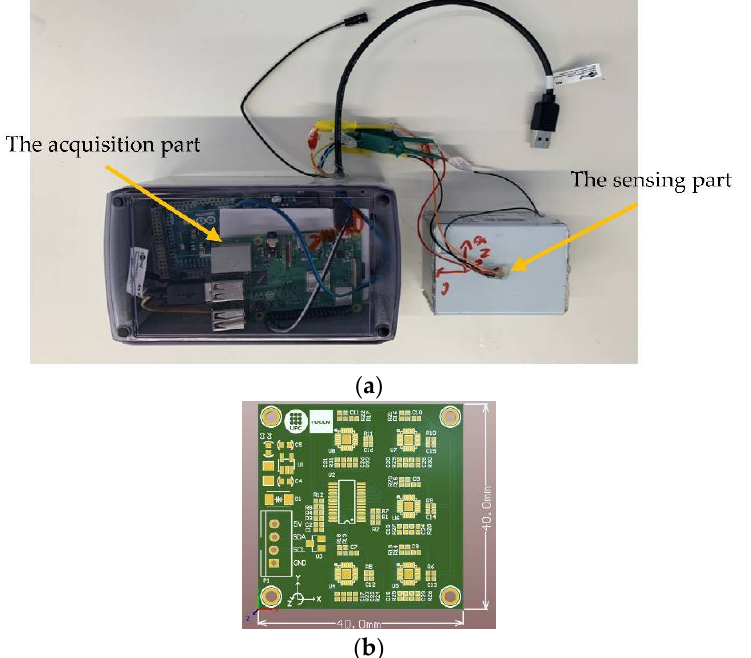
Figure 6 . An accelerometer (SARA) with its data acquisition equipment: ( a ) Boxing of SARA and its data acquisition equipment, and ( b ) compact design of the sensing part of SARA.